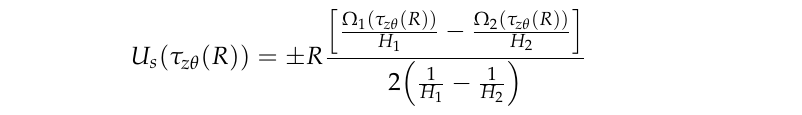
Equation (21) suggests that if plots of apparent shear rate versus reciprocal gap are drawn at constant shear stress at the edge, the slopes would be equal to 2 U s ( τ z θ ( R )) , and extrapolated intercepts would be equal to the true shear rate at the edge. Yilmazer and Kalyon [30] have used more than two gaps and thus utilized Equation (20), whereas Yoshimura and Prud’homme have used only two gaps in their analysis [115], so that: